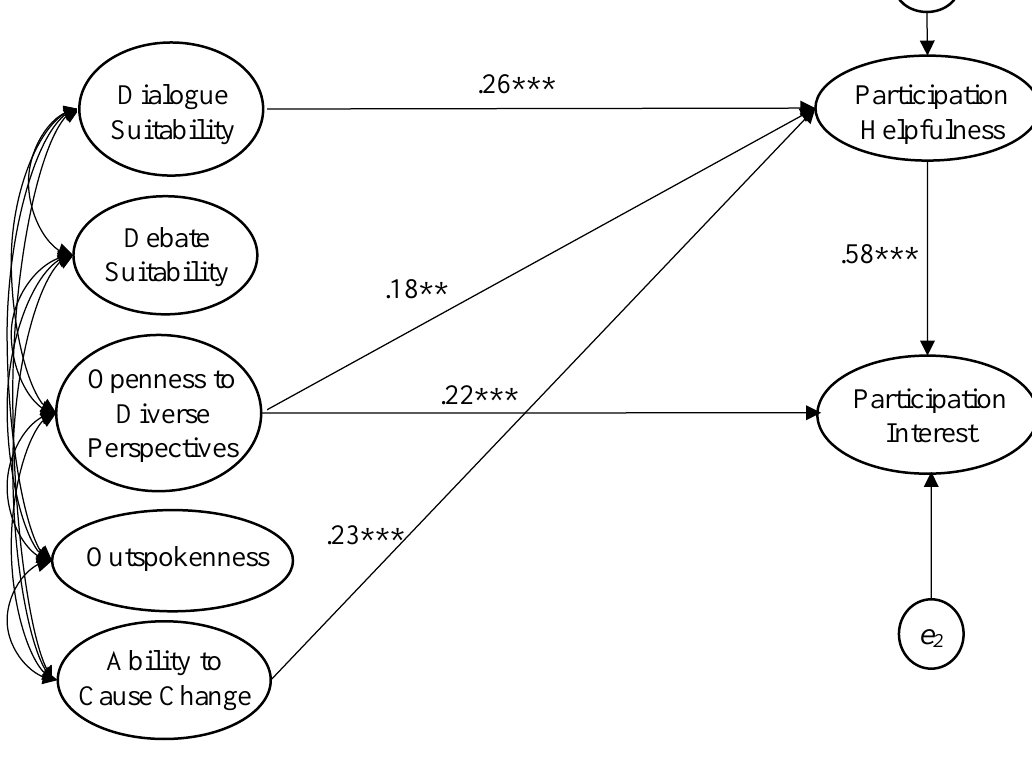
Figure 2 . Final Model of Interest in Dialogic Deliberation Participation. Model fit: χ 2 (6) = 6.397, p = .380, χ 2 /df = 1.066, IFI = .999, CFI = .999, RMSEA = .015. See Table 3 for correlations among exogenous variables. ** p <.01, *** p